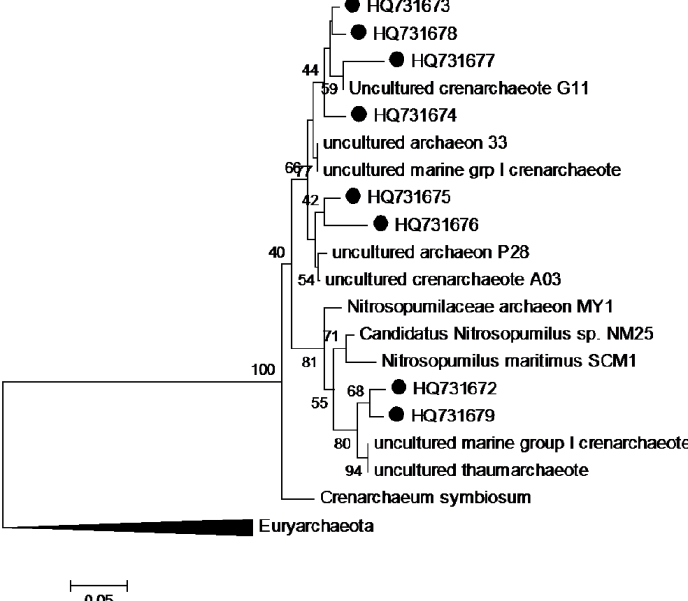
Figure 8. Evolutionary relationships of sequenced archaeal DGGE bands. Neighbour-Joining consensus tree of 16S rRNA V3 gene sequences obtained from DGGE analyses of archaeal communities in enrichment cultures. Bootstrap values were calculated from 2,000 replicates and only values >40% are shown. Scale bar represents the number of base substitutions per